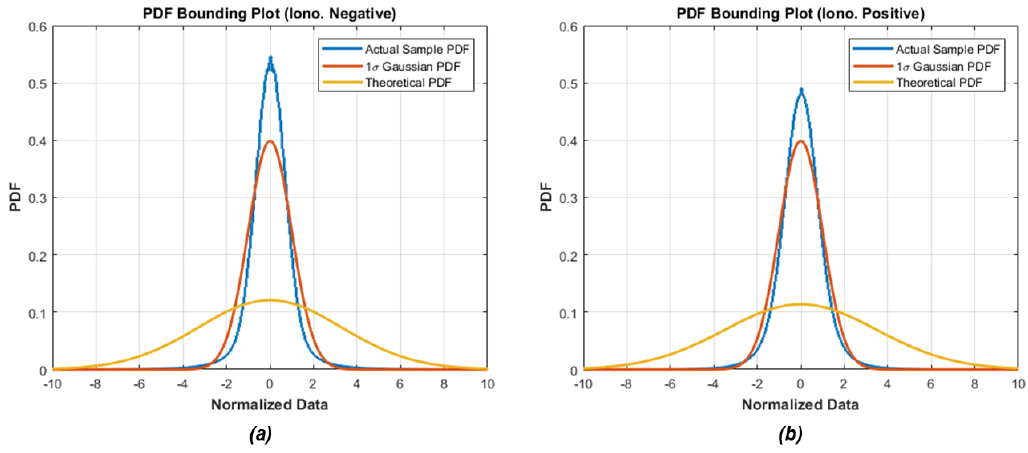
Figure 3. Probability density function of nominal monitoring values: ( a ) ionospheric negative acceleration; ( b ) ionospheric positive acceleration.